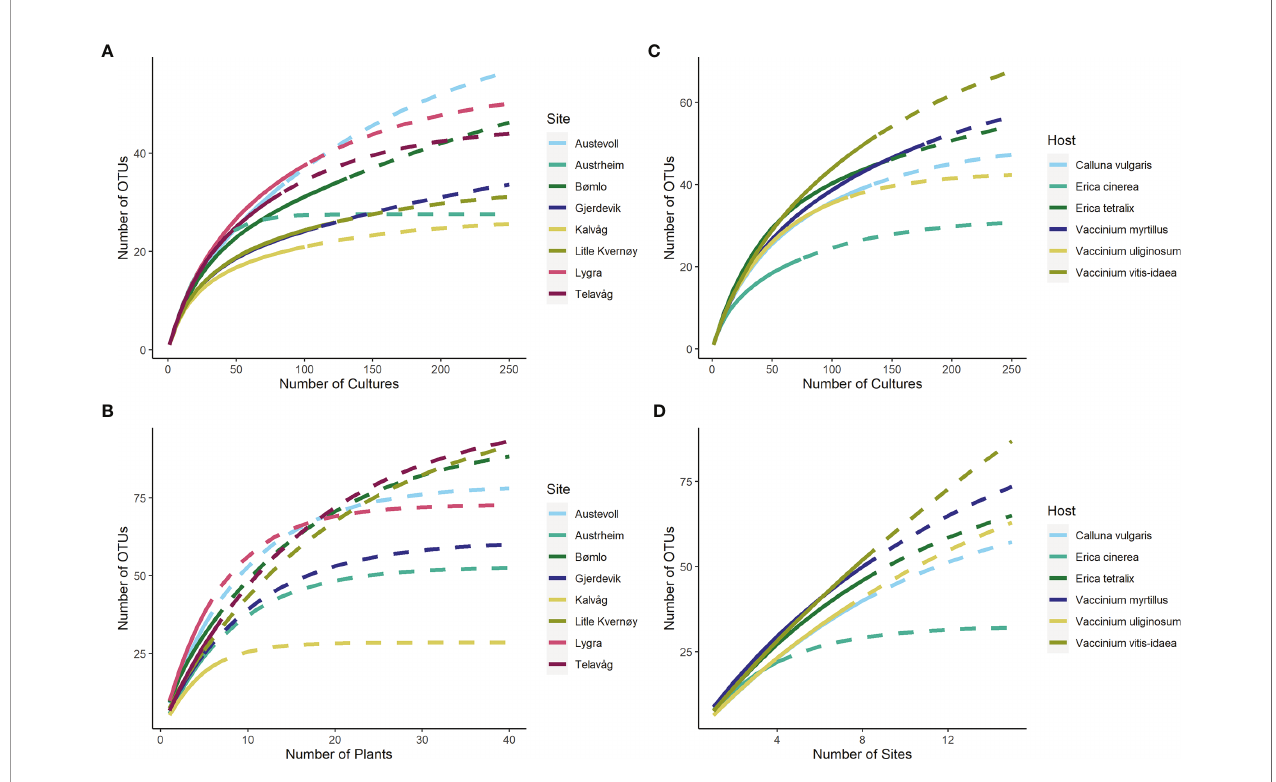
FIGURE 4 | OTU accumulation curves showing the observed and estimated alpha diversity associated with each site (A, B) and each host species (C, D) . Asymptotic estimates of total diversity are calculated based on sampling of additional cultures (A, C) , additional host plants (B) or additional sites (D)